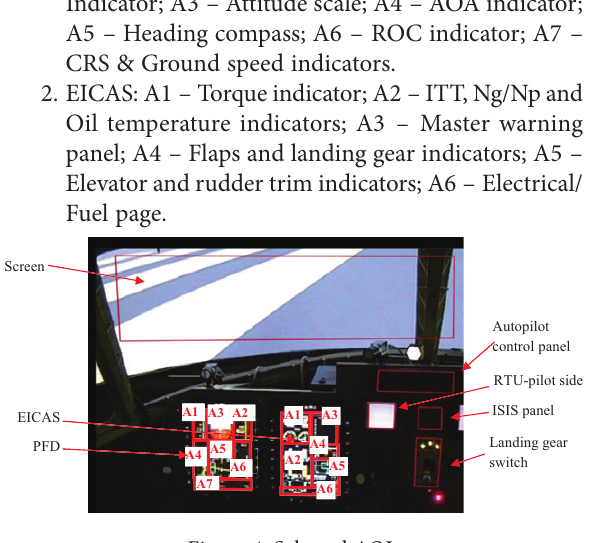
Figure 4. Selected AOIs